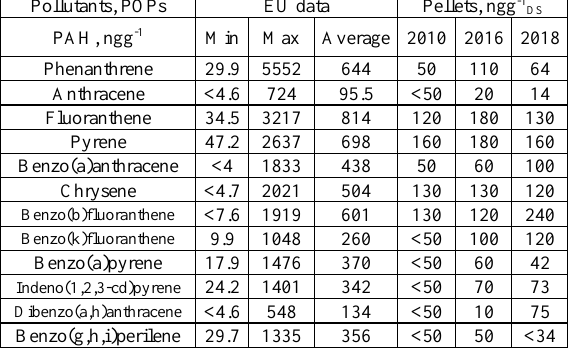
Table 8. Comparison of the FATE-SEES campaign results [21] for PAH with CWWTPL values